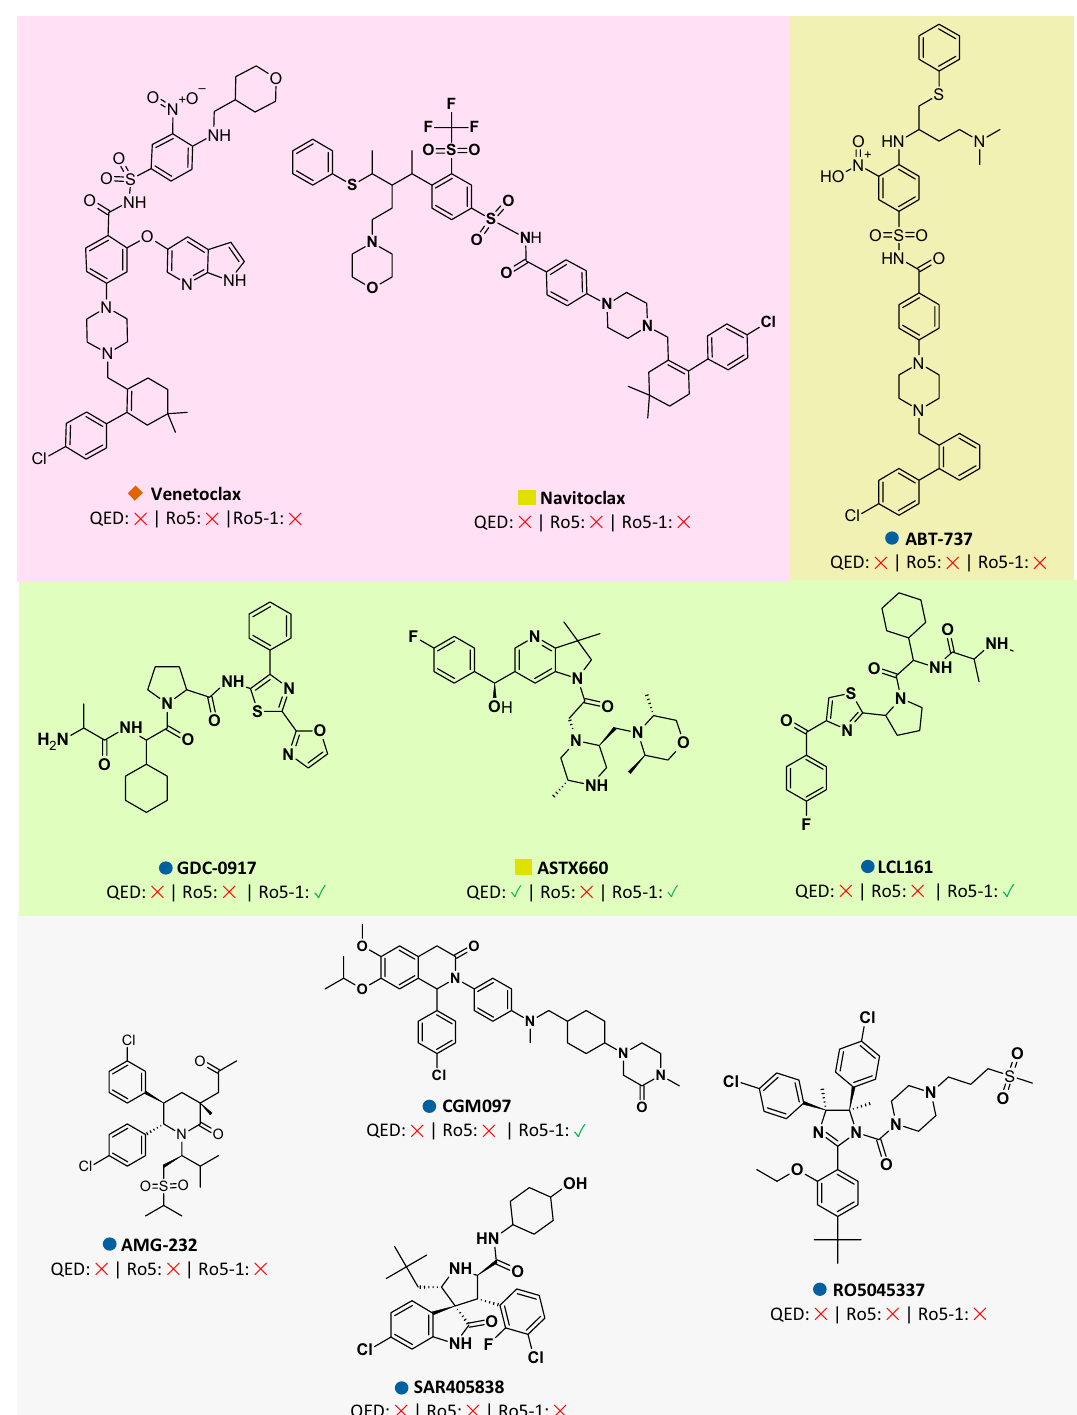
Figure 10. A subset of orally tested/approved PPI drugs assessed using standard drug-like rules (Lipinski’s and QED), and relaxed PPI drug-like rules (Ro5-1). Note: ✓ for Drug-like; ✕ for